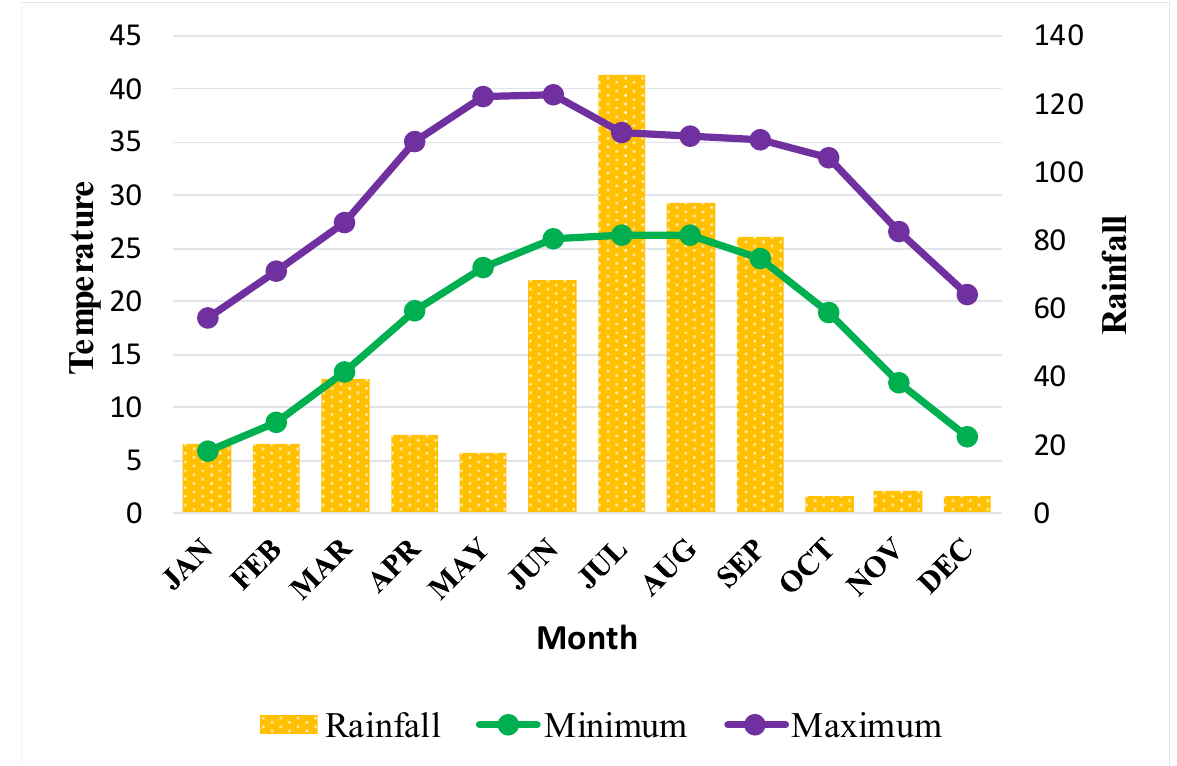
Figure 2. Climograph showing the average temperature and rainfall in district Kasur.